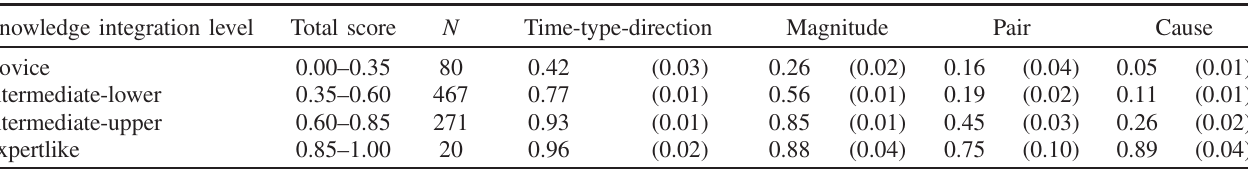
TABLE II. Mean property scores per knowledge integration level. Standard errors are given in brackets. The results are based on pre- and post-test data from all students.